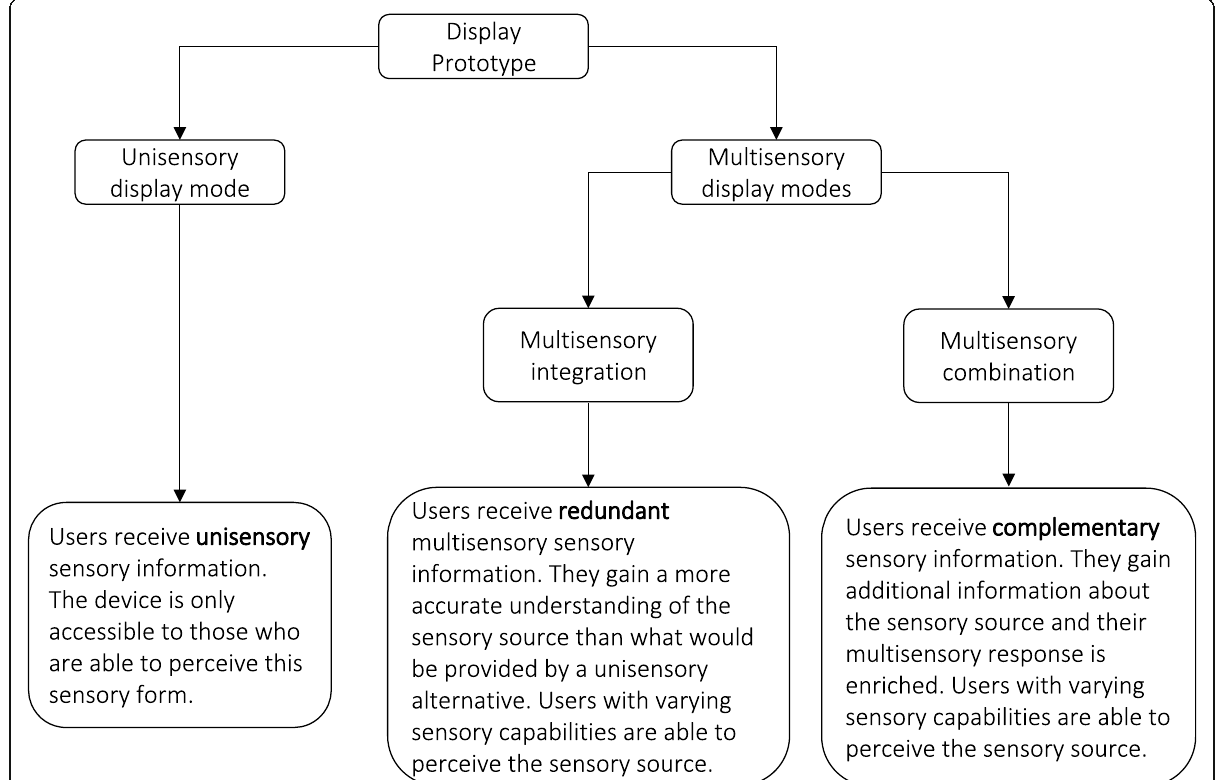
Fig. 1 Illustration of how unisensory and cross-modal display modes can utilise various sensory